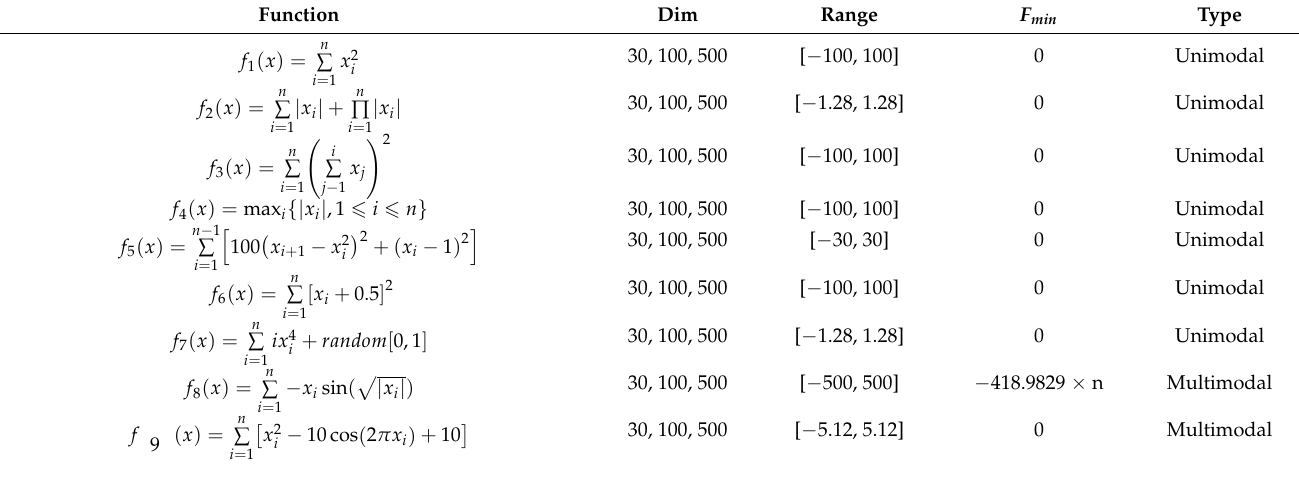
Table 1. The benchmark